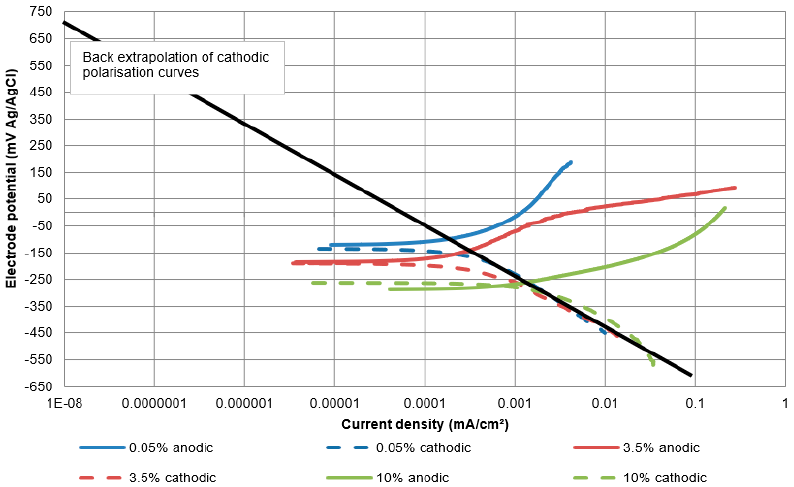
Figure 18. Illustration of back extrapolation of cathodic polarisation plots to E o for the oxygen reduction reaction for UNS S31600 in static conditions.